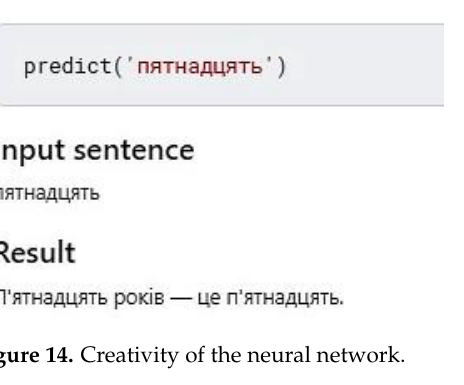
Figure 13. Change in the case of a noun.